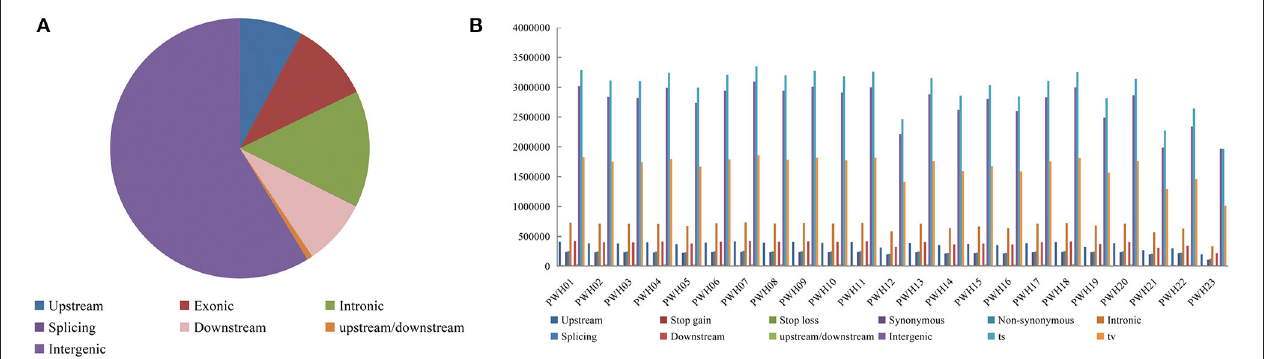
FIGURE 4 | (A) Distribution of SNPs in genomic regions. (B) Number of different SNPs in genomic regions per species.